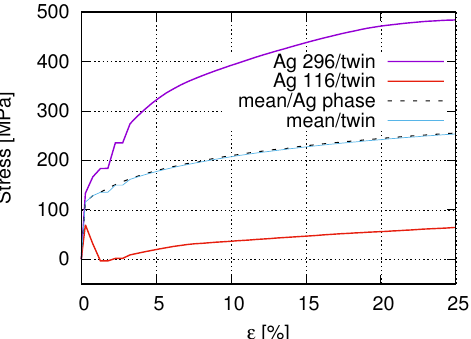
Fig. 13: The stress flow behavior according to the global strain among the 50 pairs of Σ3-twins in Fig. 12 .